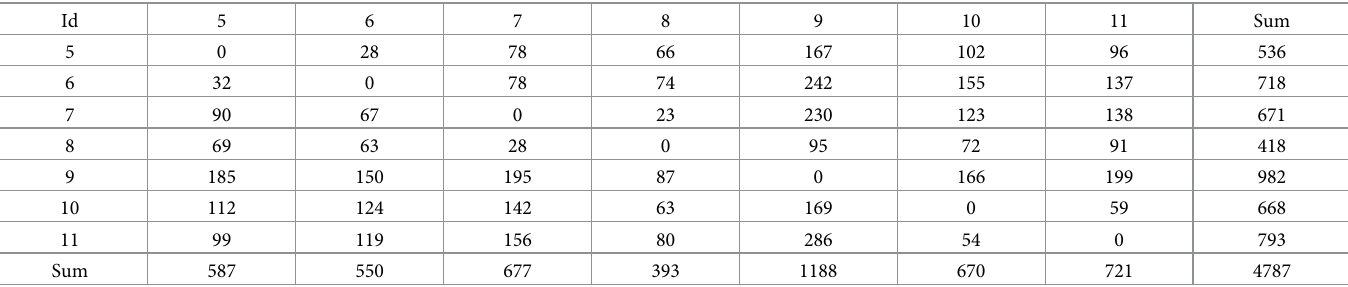
Table 2. The affected passengers’ OD demand.